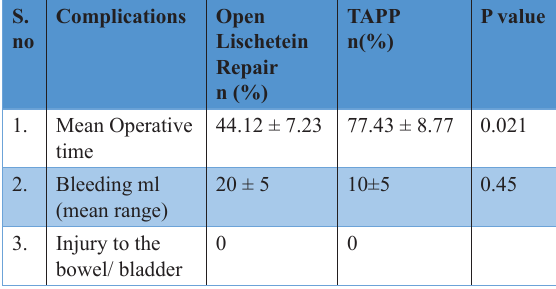
Open Lischetein Repair